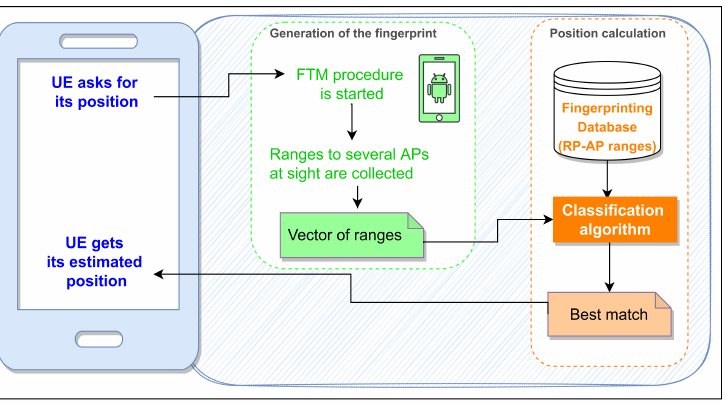
Figure 9. Flowchart of the FTM-based positioning